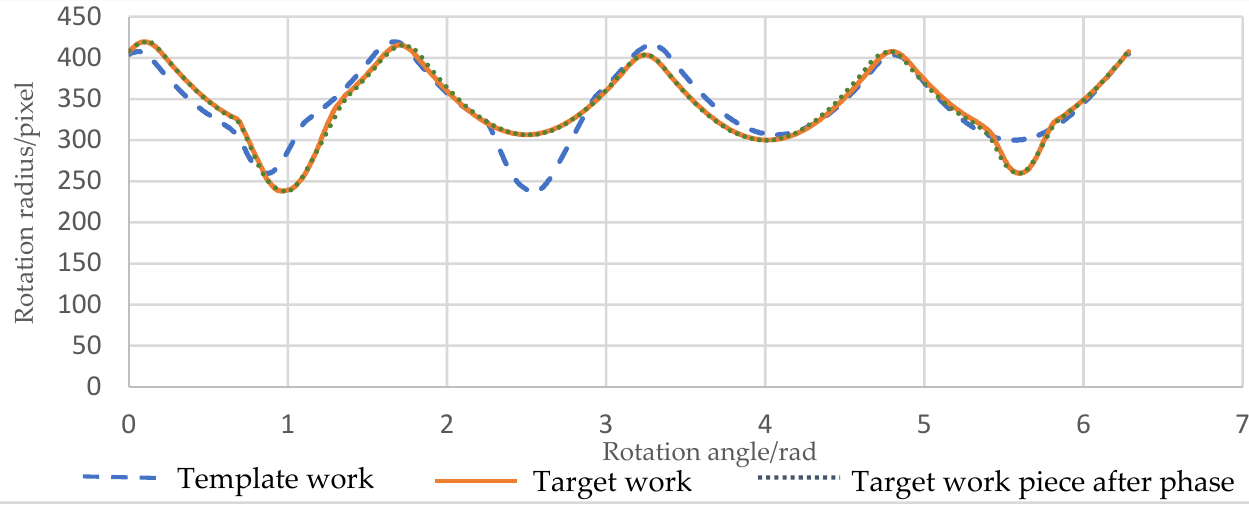
Figure 5. The template coincides with the target workpiece profile after phase move.